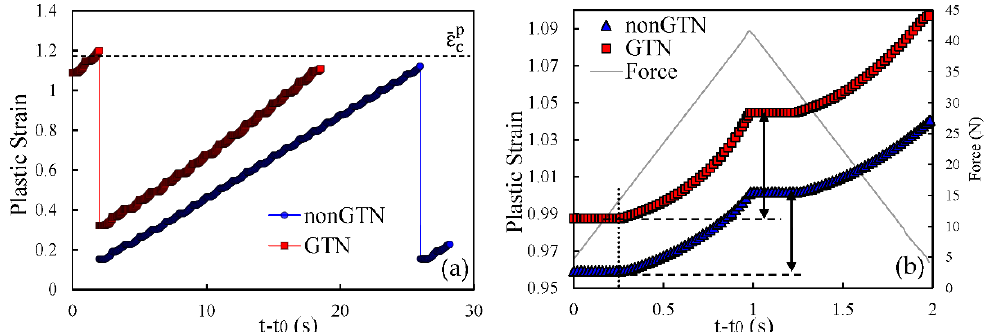
Figure 5. Comparison of the plastic strain evolution with and without GTN for a 0 = 21.5 mm. ( a ) Time period between the 36th and the 37th node releases. ( b ) A single load cycle, immediately before the 37th propagation.